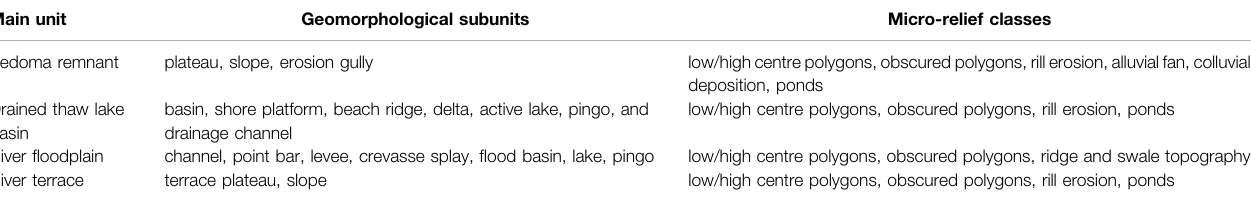
TABLE 1 | Subdivisions of the main geomorphological map units into subunits, and micro-relief classi fi cation for these